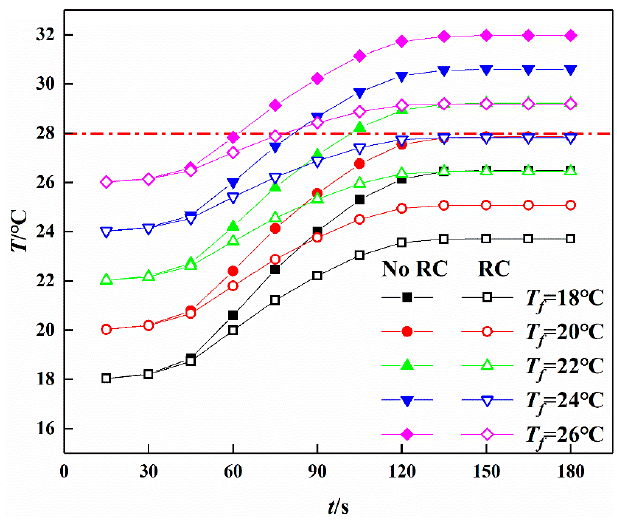
Figure 9. Variation of airflow temperature at measuring point 3 under different air supply